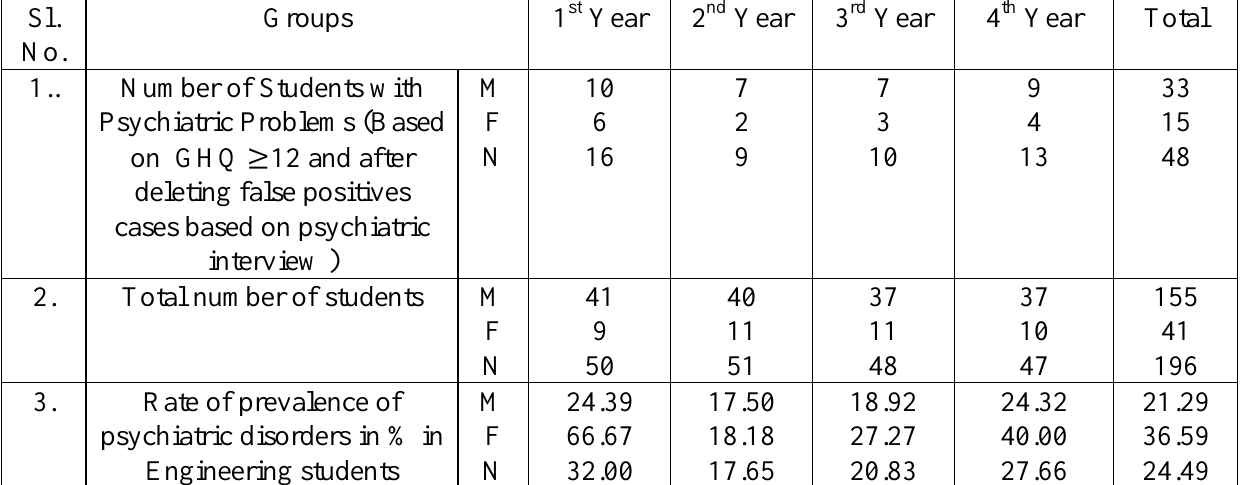
Table 1: Prevalence of psychiatric problems in Engineering College students.